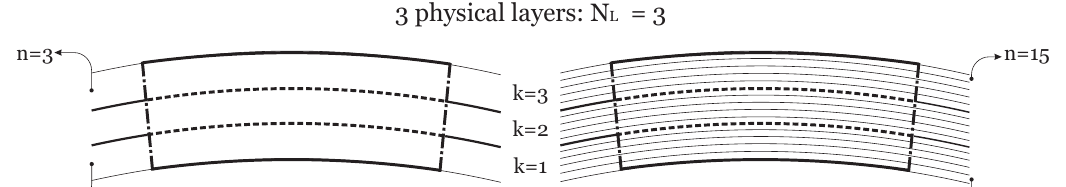
Figure 3. Three-layered structures, examples for the use of M mathematical